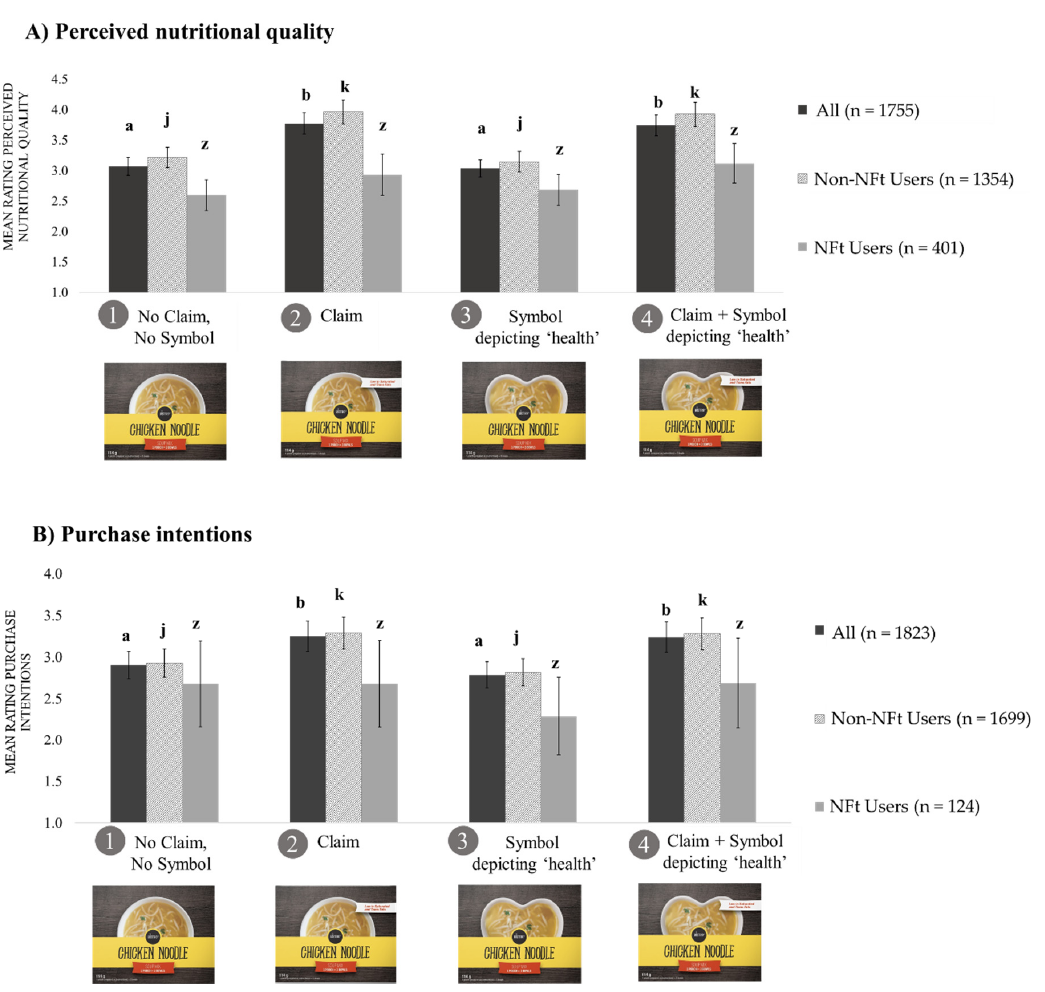
Figure 3. Means ratings of perceived nutritional quality ( A ) and purchase intentions ( B ) by condition overall and by Nutrition Facts table use (n = 1997) 1,2,3 . 1 Adjusted for gender, education, income, ethnicity, and health literacy. 2 Error bars show the standard error of the mean (SEM). 3 Because the nutritional quality of soups had no effect, participants were combined into four groups based on the label they were shown: (1) No Claim No Symbol, (2) Nutrient Content Claim, (3) Symbol depicting ‘health,’ and (4) Nutrient Content Claim + Symbol depicting ‘health.’ a,b Dark gray bars (All Participants), (means ± SEM ratings by all participants) with different superscript letters indicated statistically significant differences at p < 0.001 by the generalized linear model with Bonferroni correction. j,k Light grey bars (Non-NFt users), (means ± SEM ratings by Non-NFt users) with different superscript letters indicated statistically significant differences at p < 0.001 by the generalized linear model with Bonferroni correction. z Medium grey bars (NFt users), (means ± SEM ratings by NFt users) with different superscript letters indicated statistically significant differences at p < 0.001 by the generalized linear model with Bonferroni correction. Separate generalized linear models were conducted for each of the three.